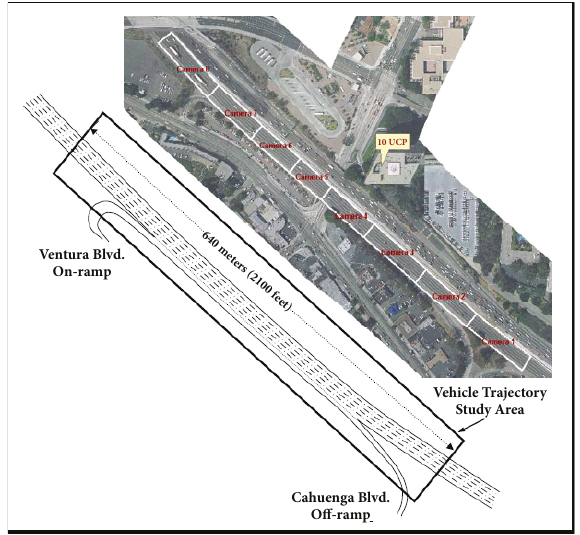
Figure 1: The section of US 101